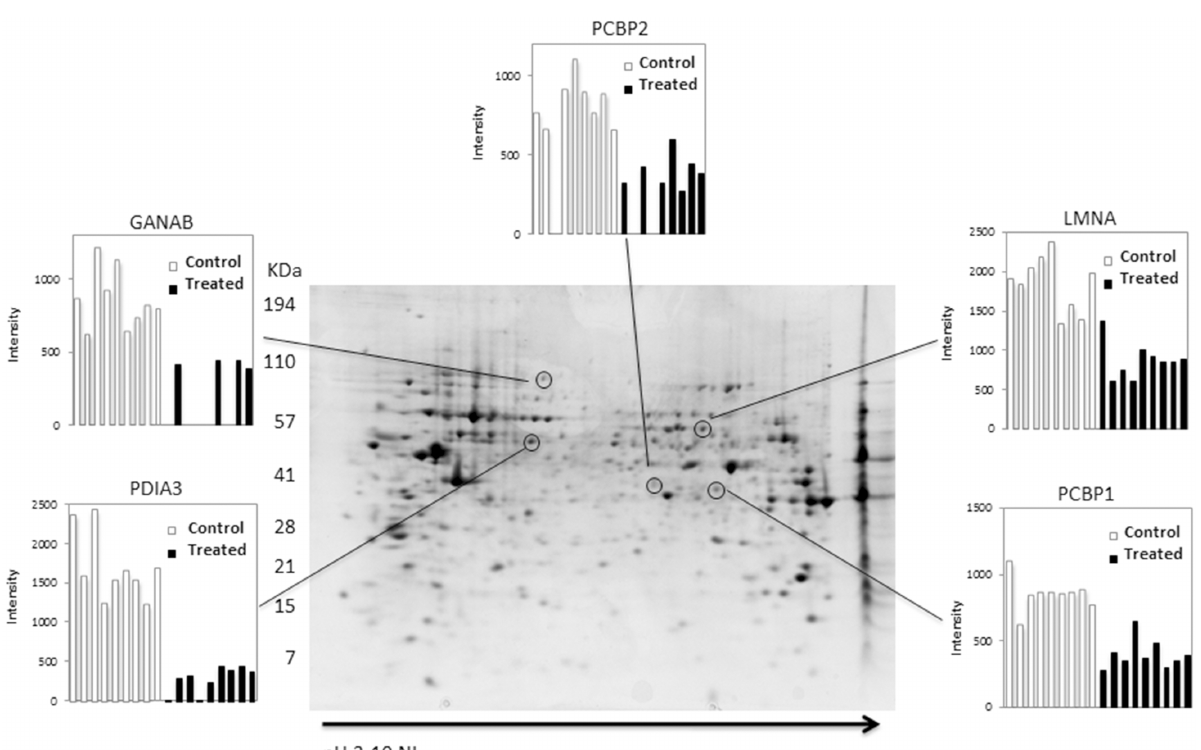
Fig 6. Representative 2-DE map of control A375 melanoma cells. Proteins were electrophoretically separated in the non-linear pH range 3 – 10 and the 200 – 15 kDa molecular mass range and visualized by colloidal Coomassie staining. The encircled spots indicate the proteins affected by rosemary extract (1:240; 24h) treatment. The relative intensities, between control and treated samples, are shown in panels. Data significance was evaluated by a Student ’ s t- test (P (cid:1) 0.05). PDA3, protein disulfide-isomerase A3; GANAB, Neutral alpha-glucosidase AB; PCBP1, poly(rC)- binding protein 1; PCBP2, poly(rC)-binding protein 2; LMNA, lamin A.